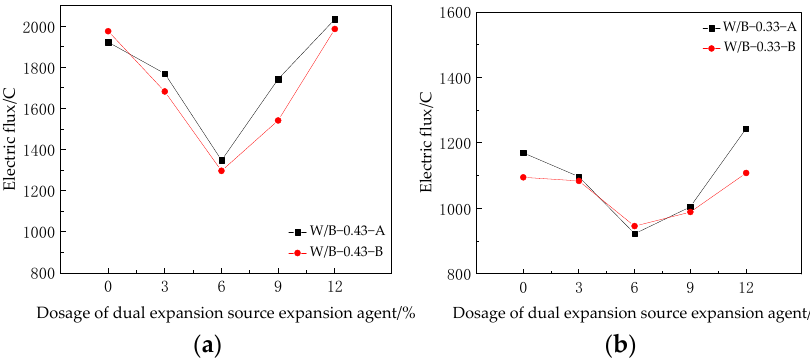
( b ) Figure 6. The carbonation depth of concrete. ( a ) W/B-0.43 with 50% mineral admixtures, ( b ) W/B-0.33 with 50% mineral admixtures. Figure 7 shows the electric flux of concrete with different dosages of expansive agents. The electric flux is used to reflect the resistance to chloride ion penetration. As shown in Figure 7, the electric flux of concrete firstly decreases and then increases with